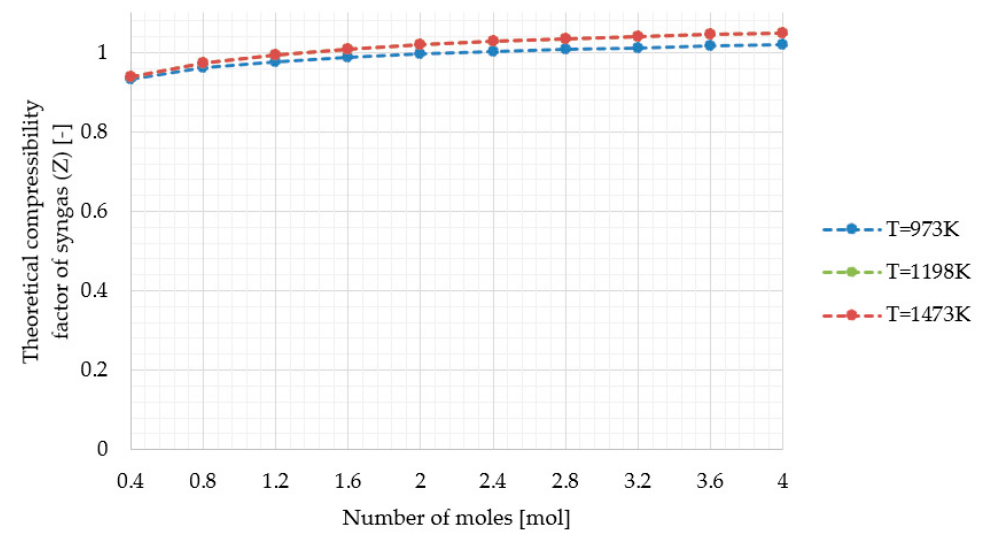
Figure 22. The theoretical value of the compressibility coefficient Z syngas derived from gasification with